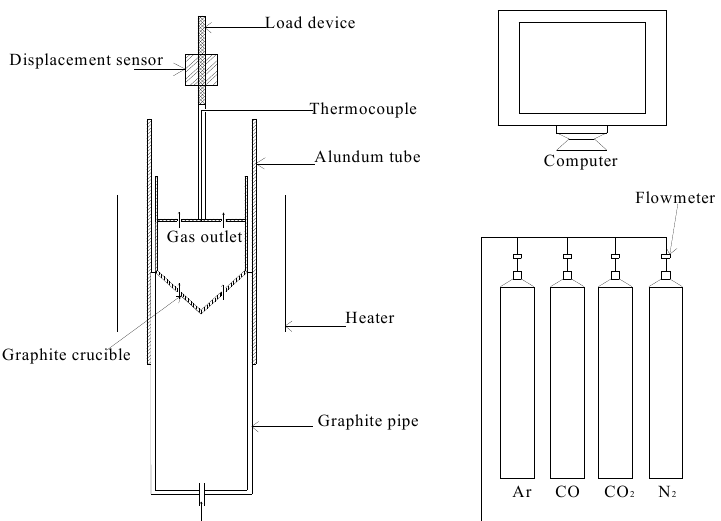
Figure 1. Schematic diagram of experimental softening and melting device.